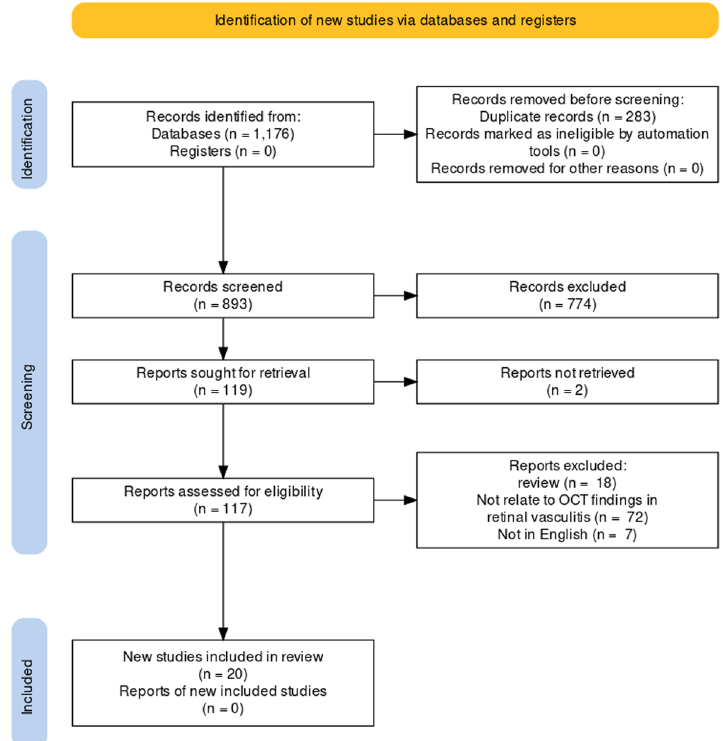
Fig. 2 PRISMA flow diagram for study